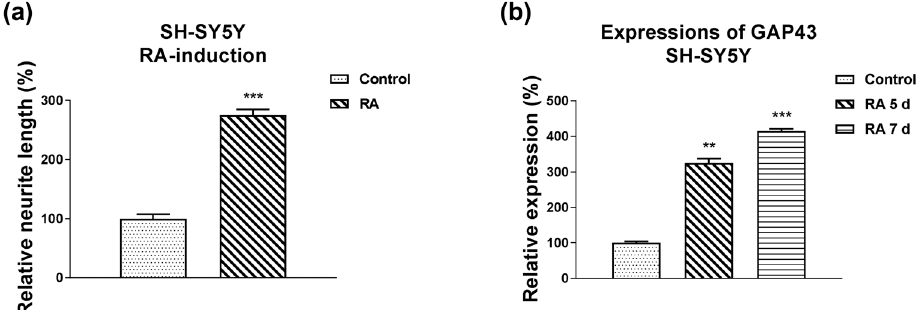
Figure S1: E ff ects of retinoic acid treatment on neuron di ff erentiation. ( a ) SH - SY5Y cells were treated with RA at 5 µM for 5 days, the relative neurite length was calculated. ( b ) Expressions of GAP43 in SH - SY5Y cells under RA treatments at 5 days and 7 days were determined by qRT - PCR. **, p < 0.01; ***, p < 0.001.